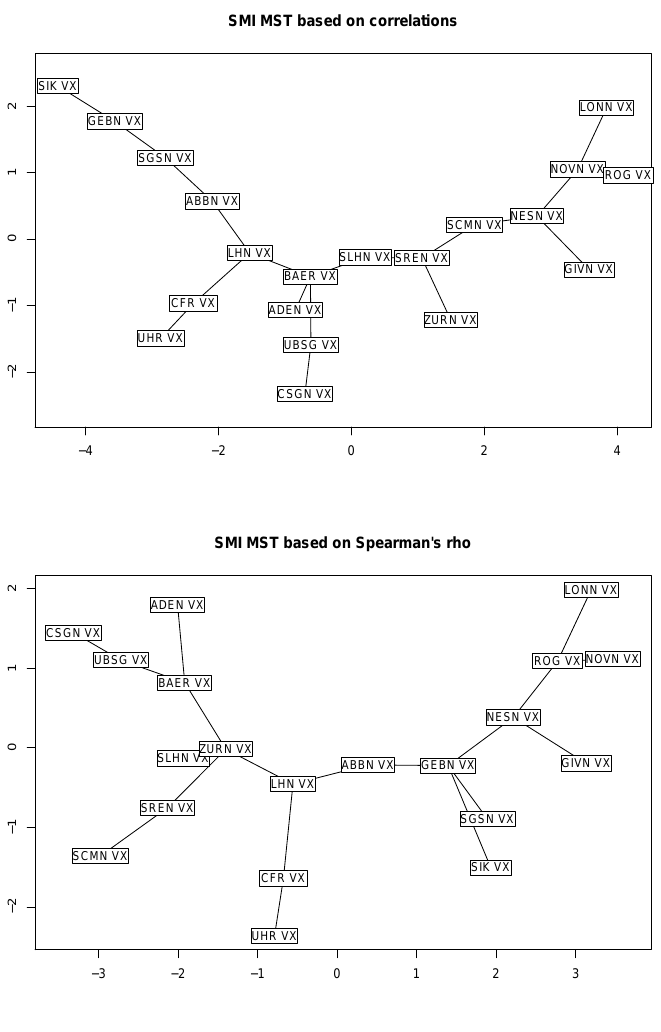
Figure 9: MSTs constructed from return data of the SMI Index constituents. Striking differences are for example the respective positions of ZURN and BAER in the